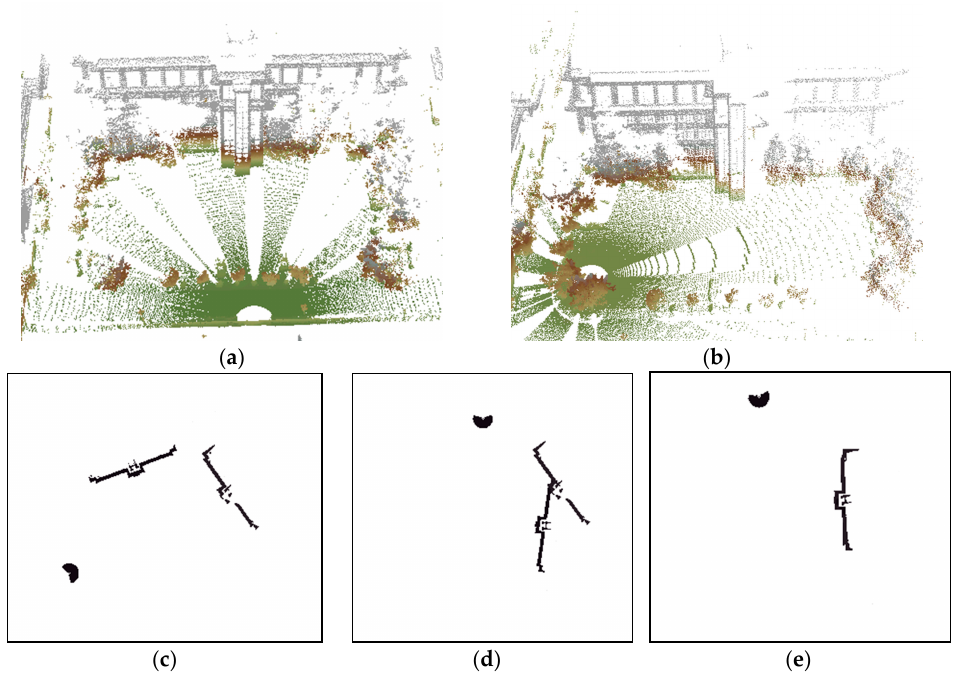
Figure 4. Search for the minimum entropy: ( a , b ) the original point clouds; ( c , d ) searching process; and ( e ) the postures corresponding to the minimum entropy.